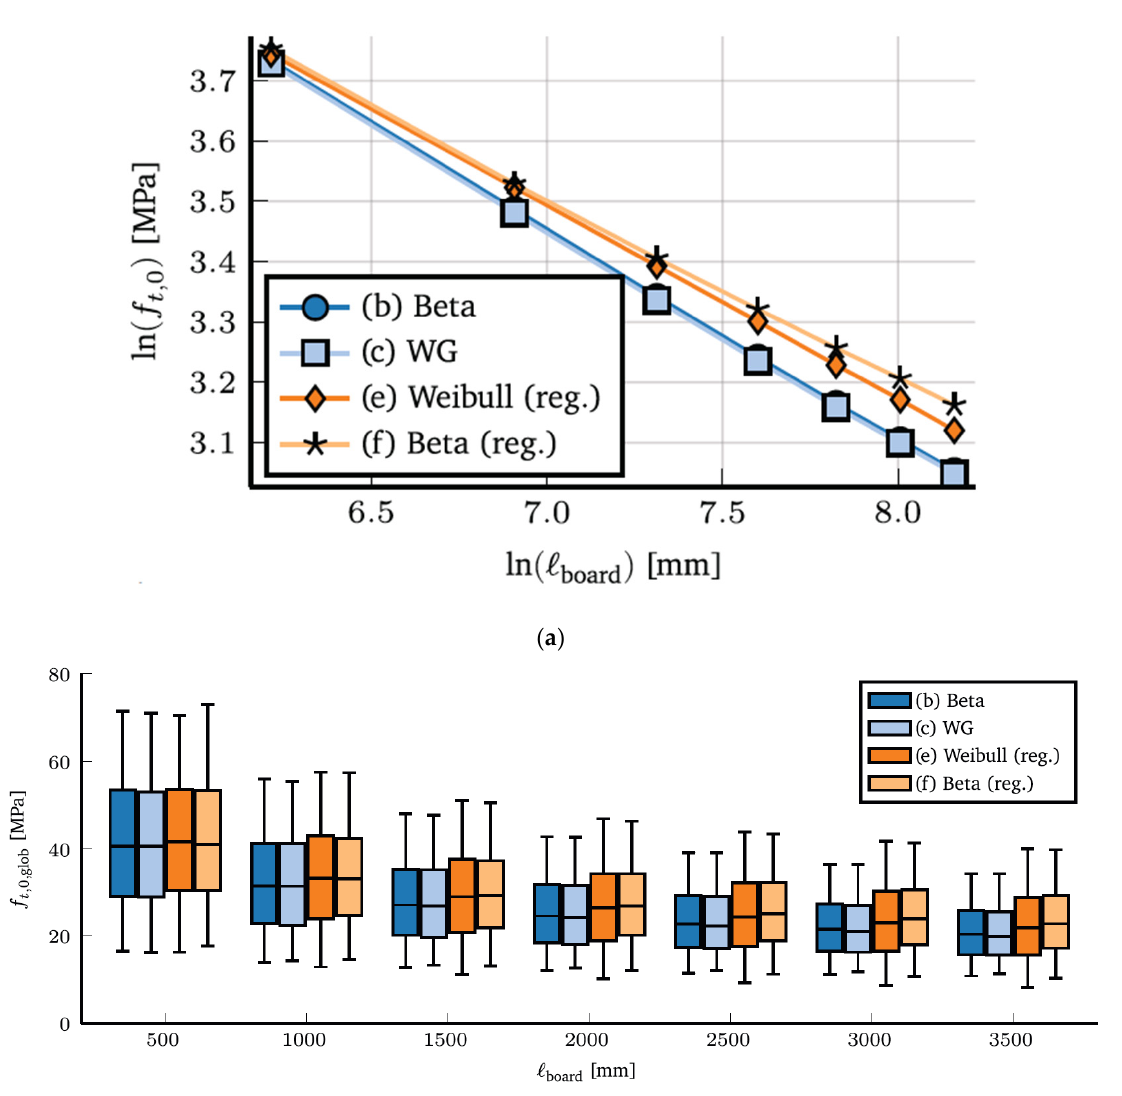
Figure 33. Plots of data obtained for modulus of rupture (MOR) for specimens of structural size against MOR for small specimens of mixed hardwoods. The lines in each plot represent various functions of structural size. ( a ) Exponential; ( b ) logarithmic; ( c ) power; ( d ) polynomial. From [160].